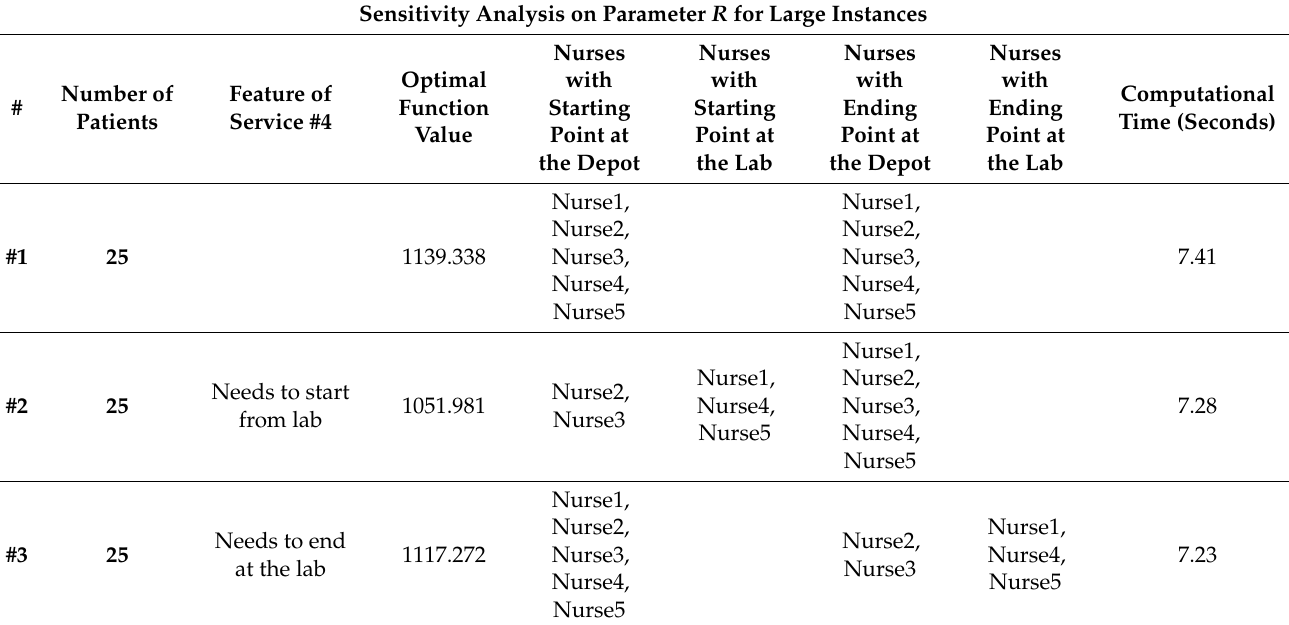
Table 10. Sensitivity analysis on parameter R for medium instances. Sensitivity Analysis on Parameter R for Large